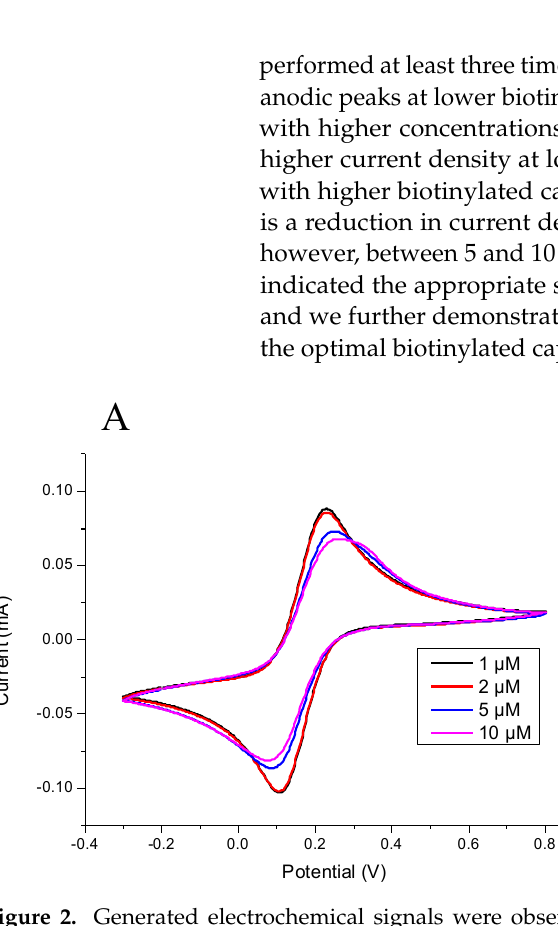
Figure 2. Generated electrochemical signals were observed from the modified surface of the screen-printed carbon electrode (SPCE) reacted with different concentrations of the biotinylated capture probe at room temperature for 1 h. We firstly confirmed by using ( A ) CV currents and ( B ) reduction potential value in different biotinylated capture probe concentrations. The optimal concentration was considered to be 5 µ M. The bar chart also shows the triple examinations with confidence intervals.